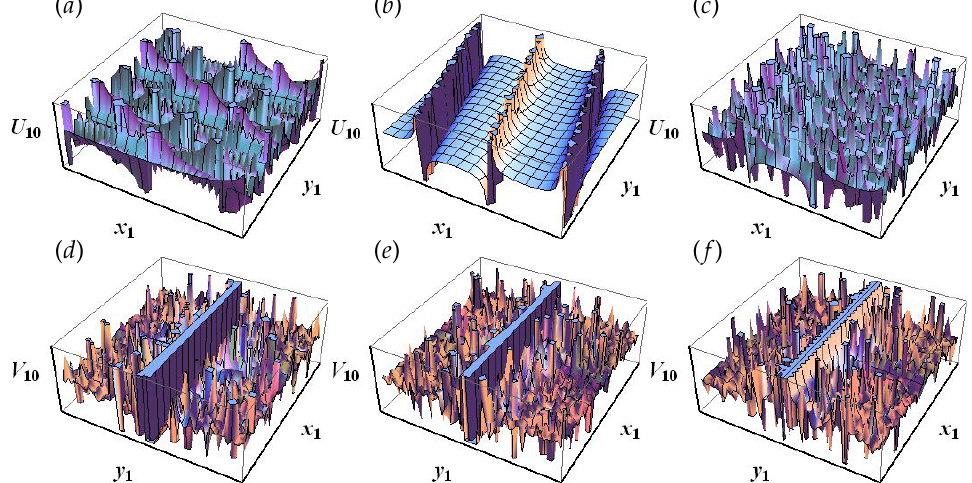
Figure 2. ( a – c ) Three-dimensional plots of U 10 ( t , x 1 , y 1 ) with the noise effect when t = 1, 1.5 and 2; ( d – f ) 3D plots of V 10 ( t , x 1 , y 1 ) with the noise effect, when t = 1, 1.5 and